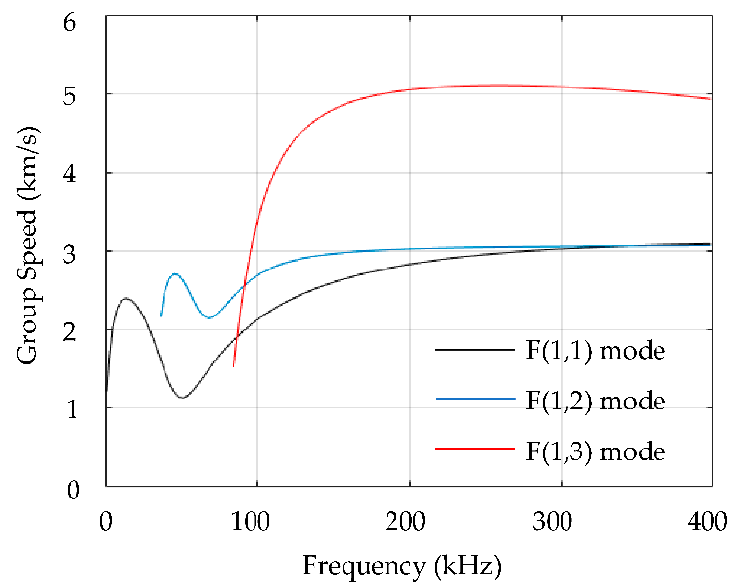
Figure 3. Group speed dispersive curves of the flexural modes in the frequency band 0–400 kHz for the